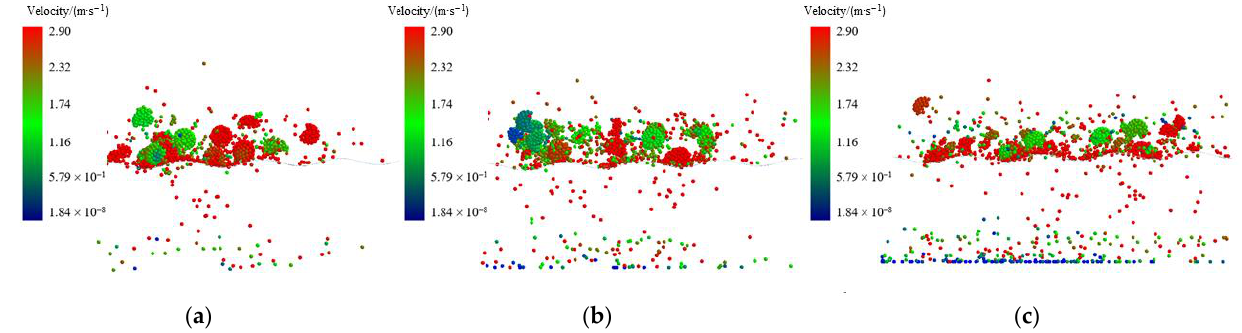
Figure 14. Velocity graph of frass agglomerates at an amplitude of 0.014 m. ( a ) t = 1.8 s. ( b ) t = 2.2 s.